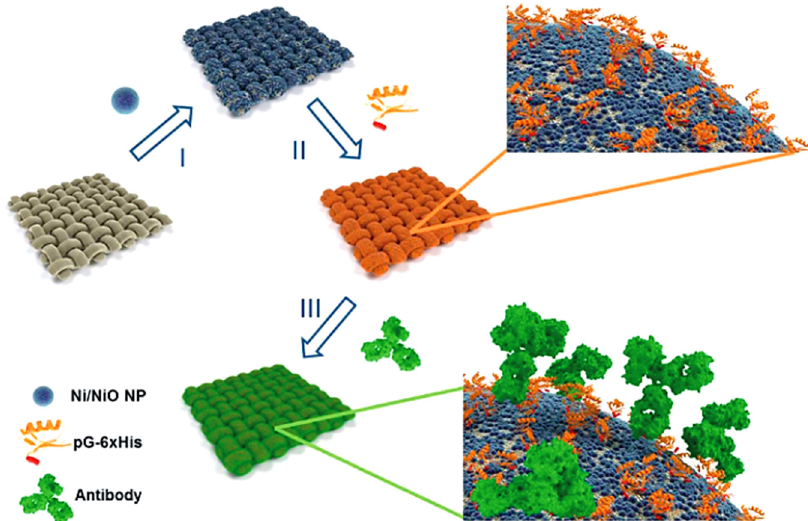
Figure 16. The schematic presentation of the bioactive scaffold preparation: (I) adsorption of Ni/NiO NPs on cellulose fiber-filter paper, (II) targeted immobilization of the polyhistidine-tagged protein G (pG-6xHis), and (III) protein G-mediated capture of antibodies. Protein G is presented by the protein G B1 domain (PDB: 1GB1, orange) bearing a 6xHis at its C-terminus (red). The antibody is an IgG2a immunoglobulin (PDB: 1IGT, green). Reprinted with permission from [345]. Copyright 2014 American Chemical Society.